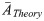
Performance variations of the pattern null depth and the channel capacity in the interference mitigation and MIMO operations.(A) Interference mitigation. (B) MIMO operation. The results obtained using A¯Theory, A¯Numeric, and A¯Measure are shown by the red line, the blue line, and black ‘*’ markers, respectively, and those of the four-port MRMP array are specified by the green line.